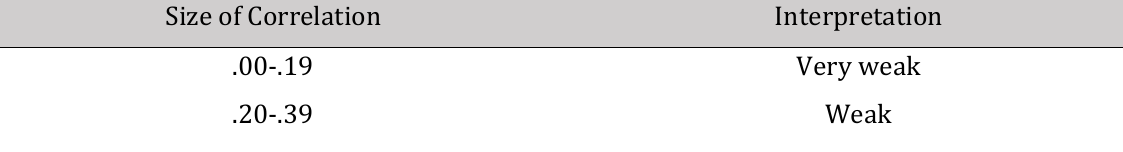
Table 3. The guidelines to describe the strength of the correlation between the variable Size of